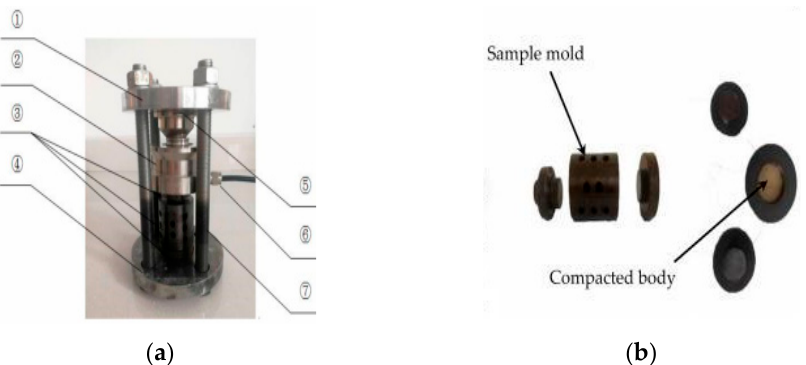
Figure 3. A schematic diagram of the expansion stress testing apparatus ( ① : top plate; ② : sensor; ③ : sample mould; ④ : bottom plate; ⑤ : anti-load measuring head; ⑥ : data acquisition system; ⑦ : constrained screw). ( a ) Expansion stress test apparatus; ( b ) Sample mould.